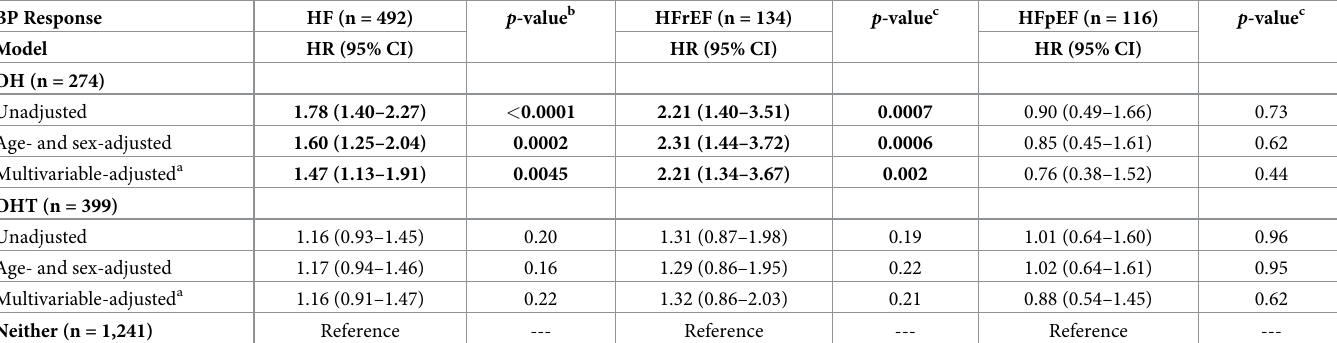
Table 2. Association of orthostatic blood pressure response with risk of HF and HF subtypes. BP